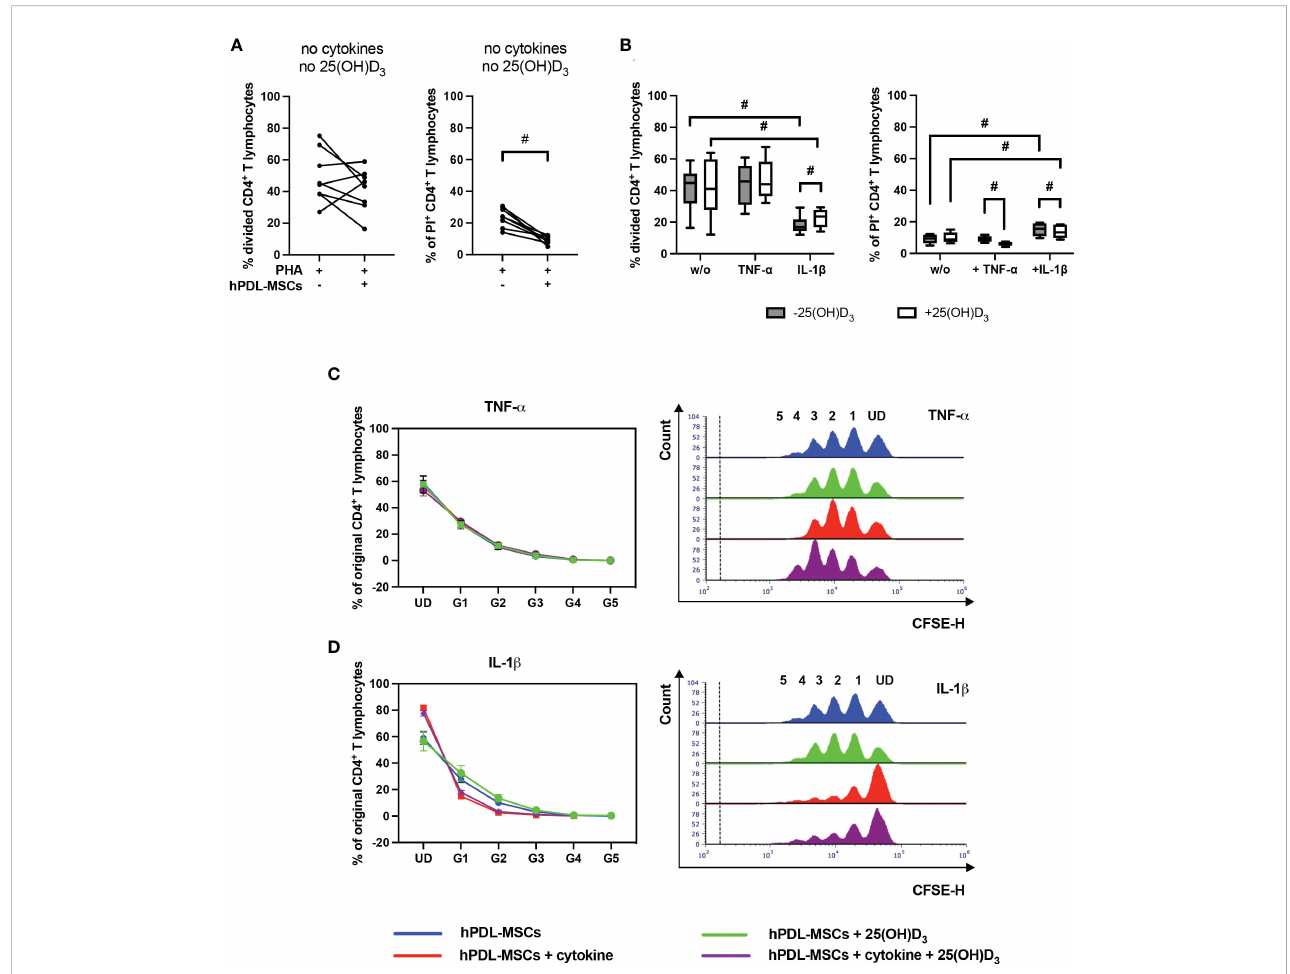
FIGURE 2 25(OH)D 3 differently affects CD4 + T lymphocyte proliferation and viability via hPDL-MSCs depending on the present cytokine. After fi ve days of culturing CD4 + T lymphocytes indirectly with hPDL-MSCs, fl ow cytometry analysis was used to determine the proliferation and viability of CD4 + T lymphocytes by CFSE and PI staining, respectively. (A, B) reveals the percentage of original CD4 + T lymphocytes that are divided and the percentage of PI + CD4 + T lymphocytes. (C, D) shows the number of original CD4 + T lymphocytes as a percent of the total number of original cells for each cell generation (UD = undivided cells, G1-G5 = generation 1 – generation 5). Additionally, (C, D) includes representative histograms showing the number of CD4 + T lymphocytes for all generations (UD and 1-5). Data were obtained from fi ve (B, C, D) and eight (A) experimental repetitions using hPDL-MSCs from